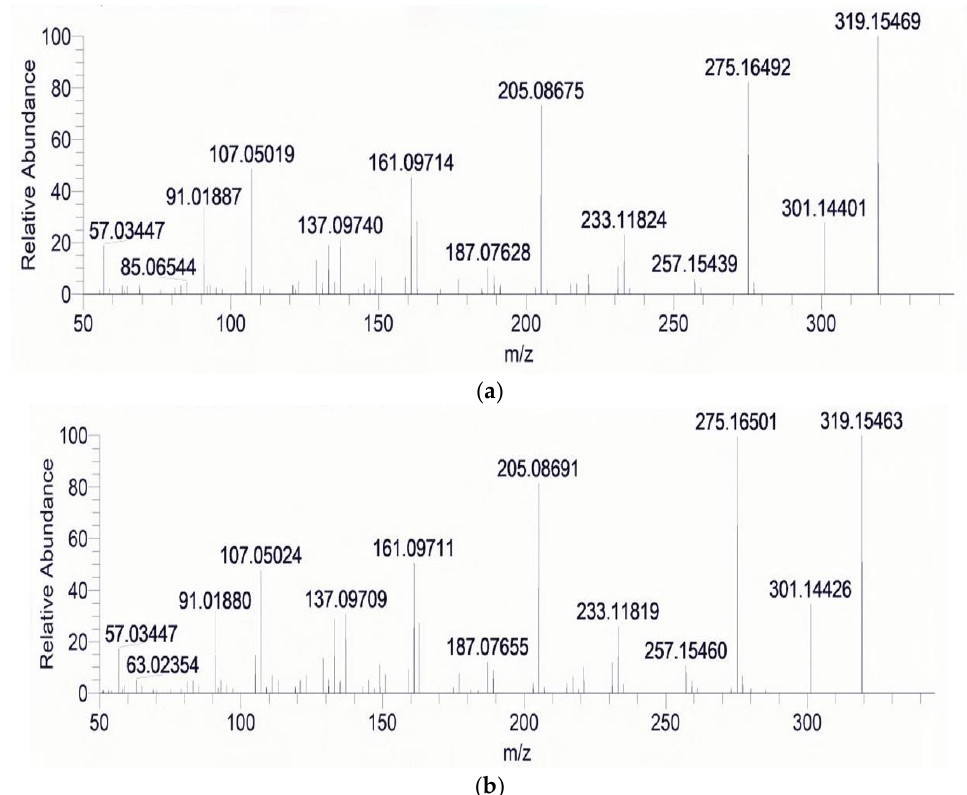
Figure 4. MS 2 spectra of ZEN in the standard solution ( a ) and contaminated sample ( b ).